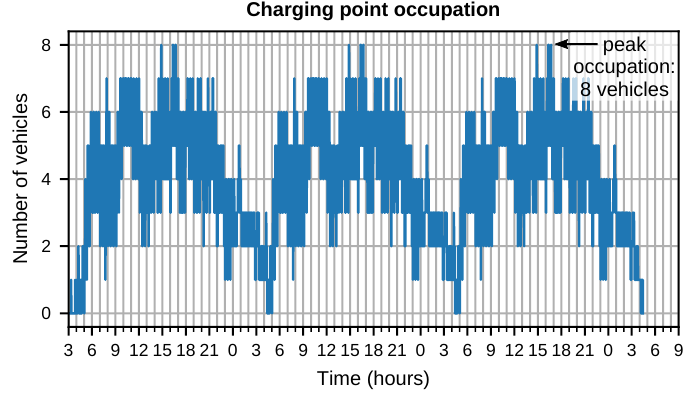
Figure 13. Example of opportunity charging (OC) charging point occupation.